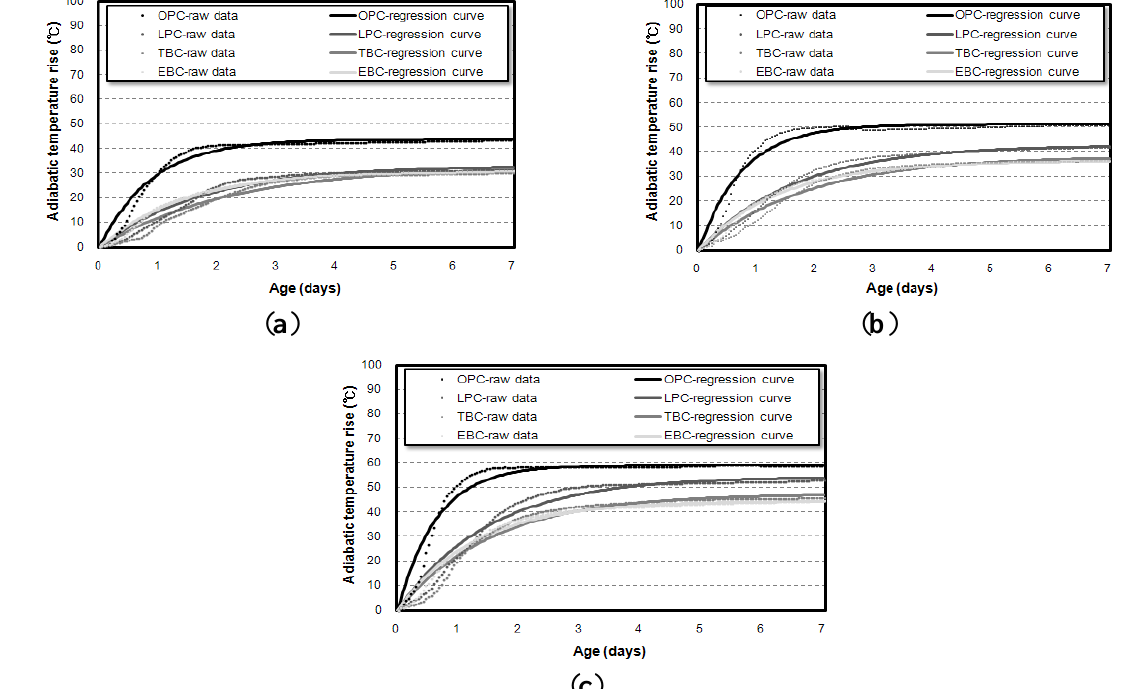
Figure 7. Results of the 30 L adiabatic temperature rise test depending on binder types. ( a ) Unit weight of binder: 300 kg/m 3 ; ( b ) unit weight of binder: 400 kg/m 3 ; ( c ) unit weight of binder: 500 kg/m 3